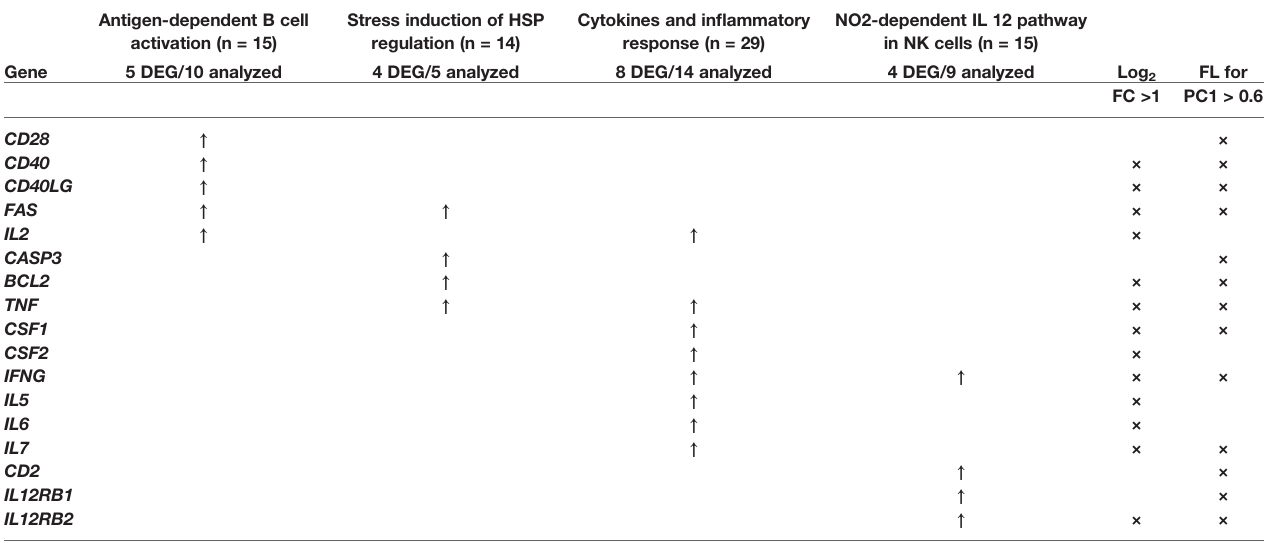
TABLE 4 | List of genes differentially expressed in IND and HD subjects which have shown to be involved in the BioCarta pathways antigen-dependent B cell activation (BIOCARTA_ASBCELL_PATHWAY), stress induction of HSP regulation (BIOCARTA_HSP27_PATHWAY), cytokines and in fl ammatory response (BIOCARTA_INFLAM_PATHWAY), and NO2-dependent IL 12 pathway in NK cells (BIOCARTA_NO2IL12_PATHWAY) enriched in IND phenotype according to GSEA